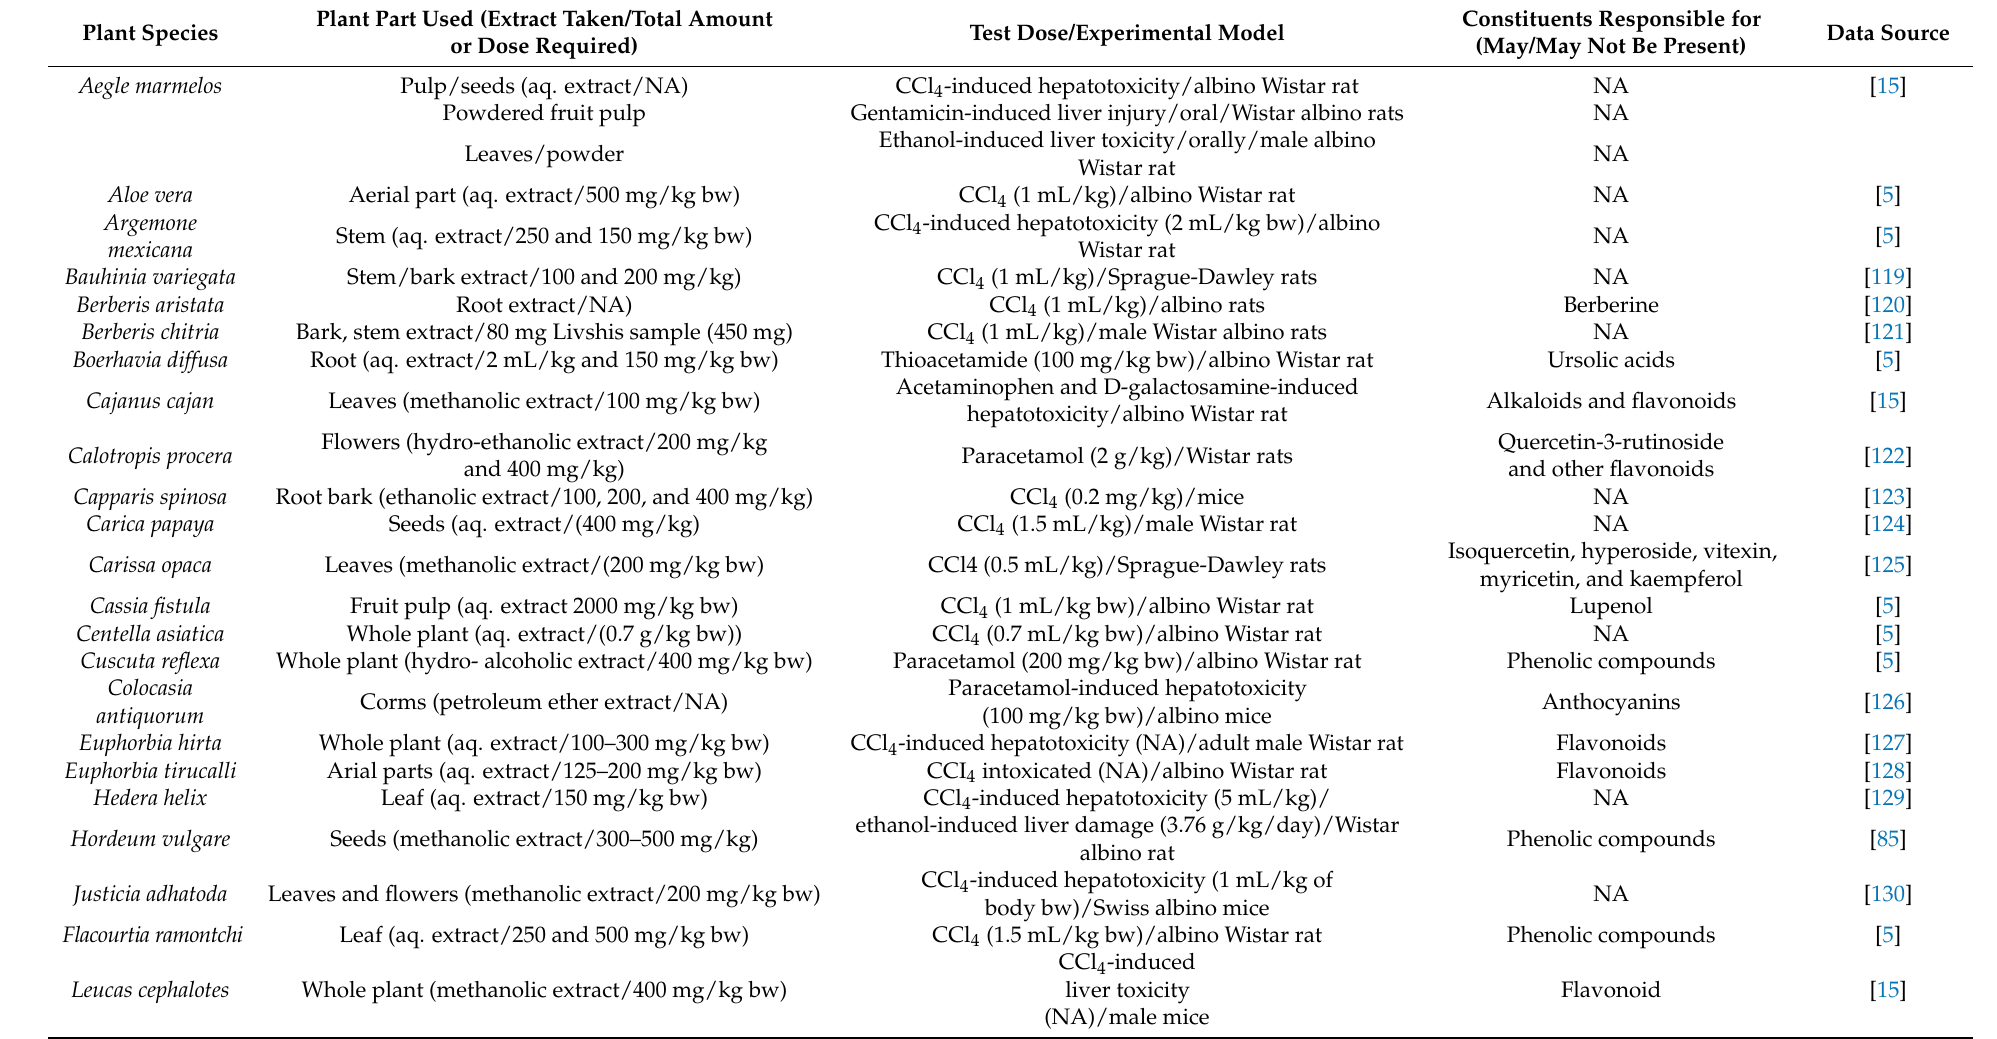
Table 4. In vivo evidence of ethnomedicinal plants used for the treatment of jaundice/hepatoprotective